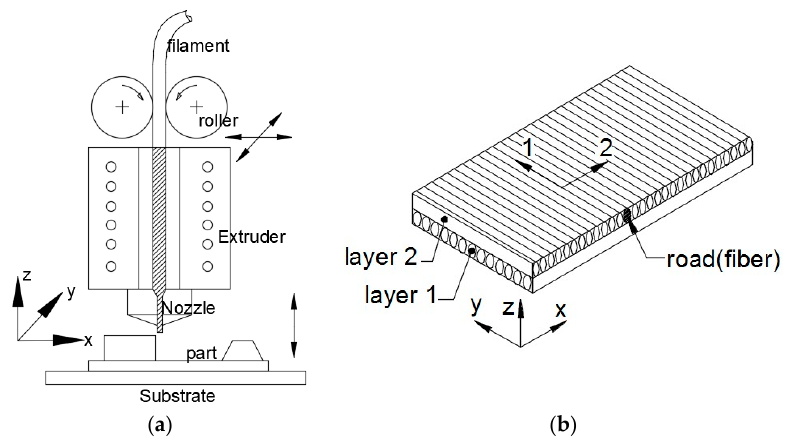
Figure 3. ( a ) FDM process; ( b ) plate fabricated with FDM process in 0° and 90° raster orientation.